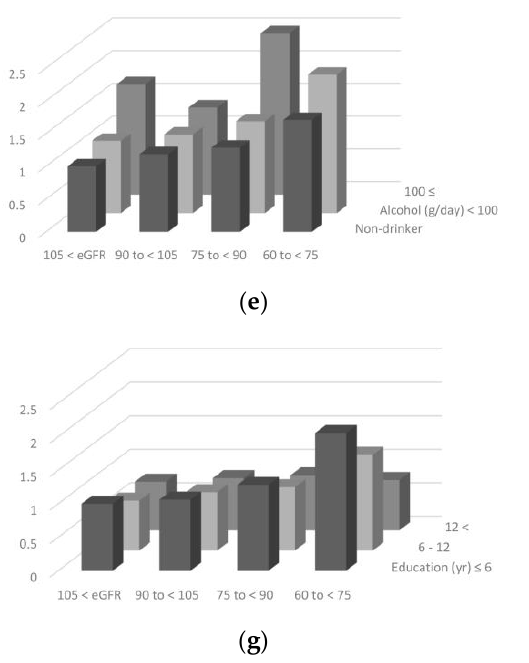
Figure 3. Joint interaction of eGFR with potential confounders on incident metabolic syndrome. Plots show HR and p -values for interactions by eGFR category. ( a ) age, ( b ) gender, ( c ) BMI, ( d ) exercise, ( e ) alcohol consumption, ( f ) smoking status, and ( g ) education. HR: hazard ratio; eGFR: estimated glomerular filtration rate; BMI: body mass index; MET: metabolic equivalent of task.